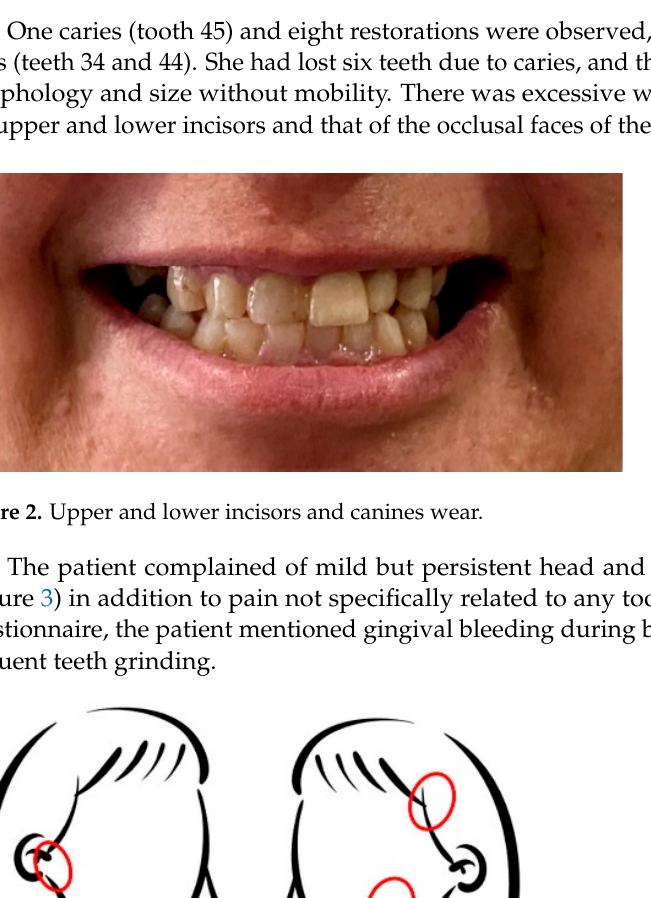
Figure 1. Superior arch localized gingivitis: redness, oedema, and modification of the normal teeth contour.